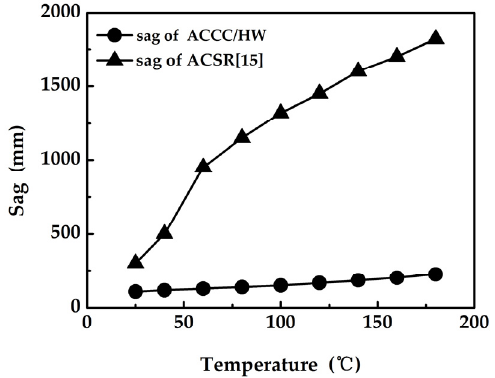
Figure 8. The sag curve of ACCC and ACSR with similar structure [21].